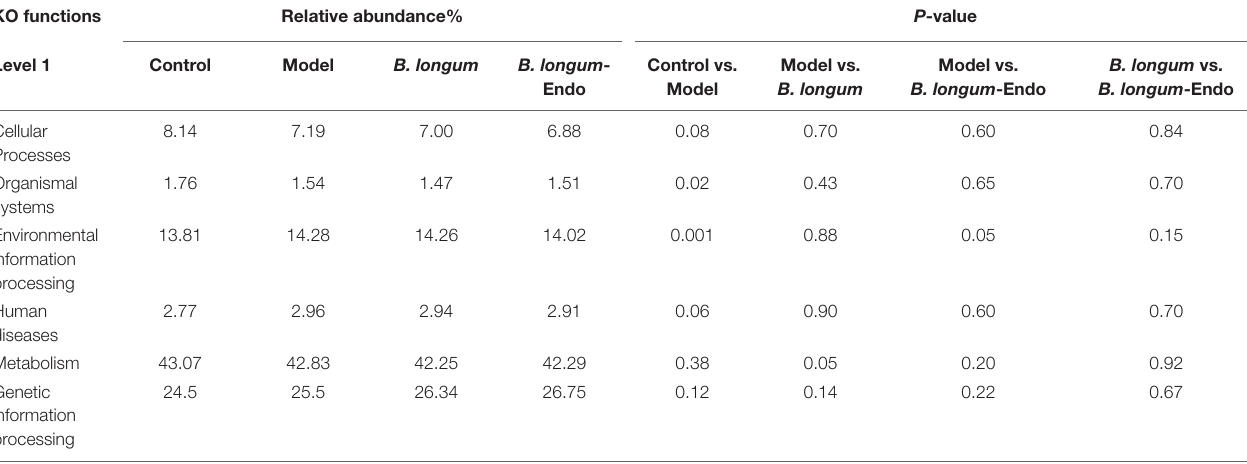
TABLE 4 | Predicted KEGG functional pathway differences at the first level using PICRUSt. KO functions Relative